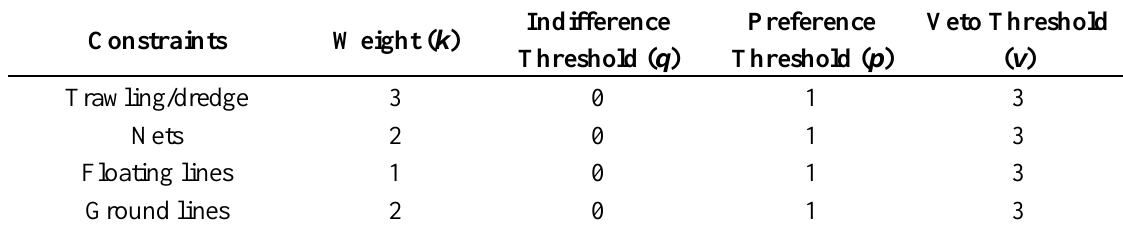
Table 1. Threshold values and weights.